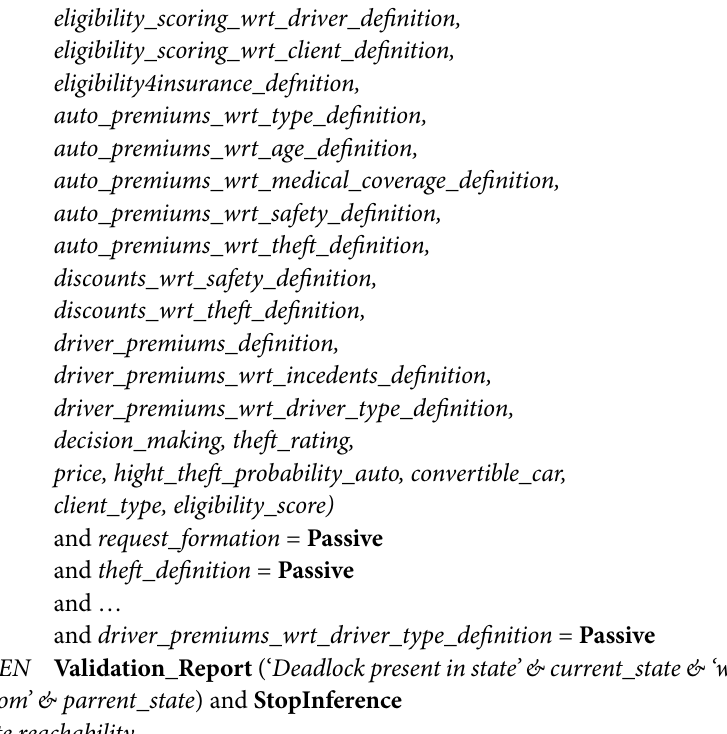
fig. 4. Static verification in